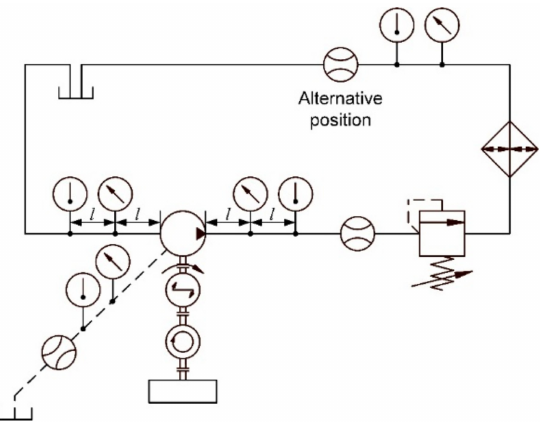
Figure 1. Basic measurement system for determining derived capacity and steady-state performance of a unidirectional positive displacement pump according to standards ISO 8426 and ISO 4409 [2,3]. Control of pressure difference across the pump ports requires some sort of loading